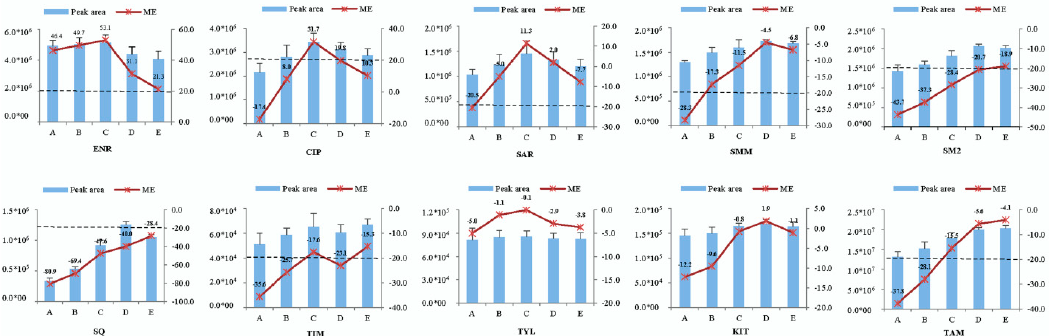
Figure 4. Influence of different sample dilution times on matrix effects of 10 veterinary drugs in chicken muscle matrices at 10 μ g L − 1 ( n = 20). (A) 0.25 multiple, (B) 0.5 multiple, (C) 1 multiple, (D) 5 multiple, (E) 10 multiple.